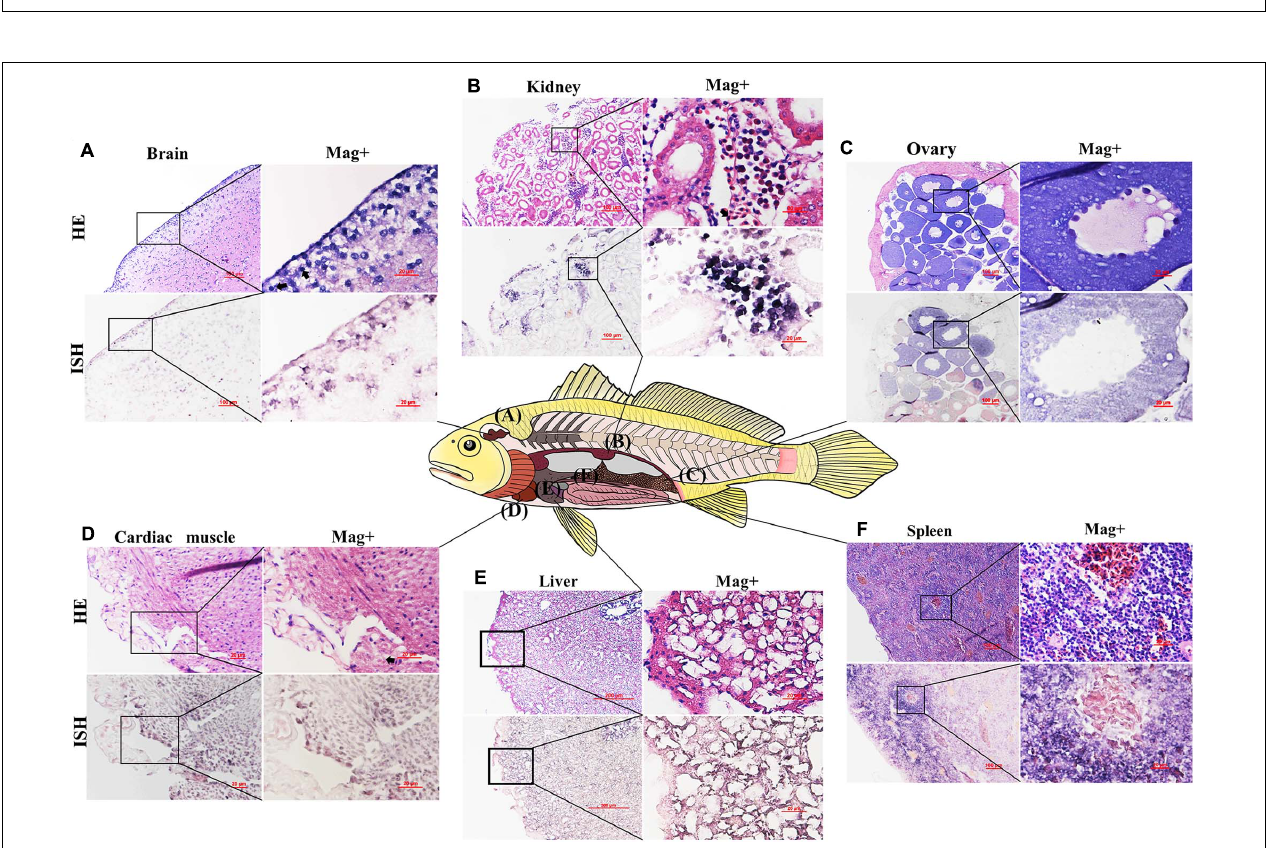
FIGURE 5 | Micrographs of H&E staining and in situ hybridization for the brain, kidney, ovary, cardiac muscle, liver, and spleen of the Larimichthys polyactis naturally infected with CMNV. (A) brain, (B) kidney, (C) ovary, (D) cardiac muscle, (E) liver, and (F) spleen. Scale bar = 100 and 20 µ m for low and high magnifications, respectively. HE, H&E stained; ISH, in situ hybridization; Mag + , high magnification.